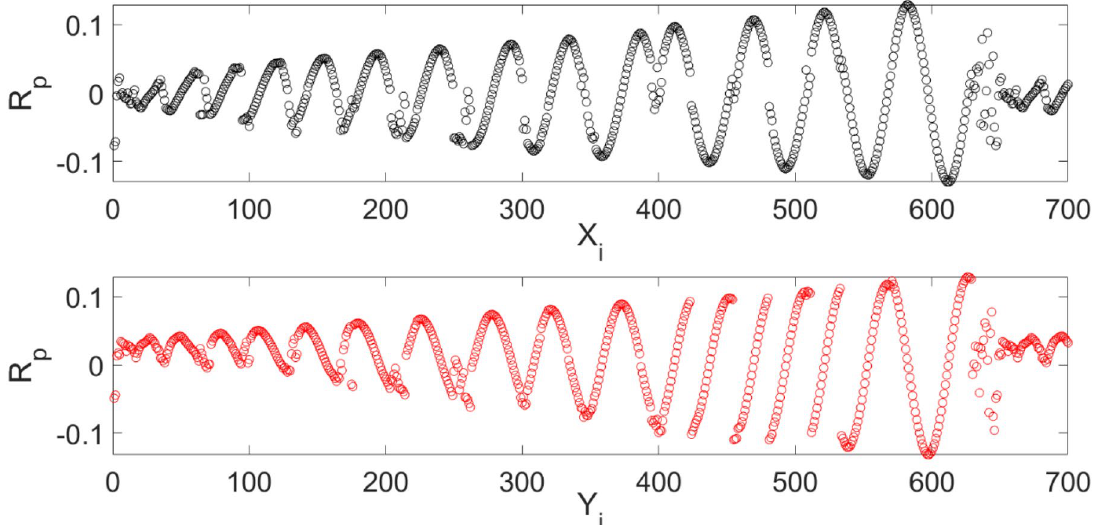
Figure 4. Random position of each node computing position for 700 selection